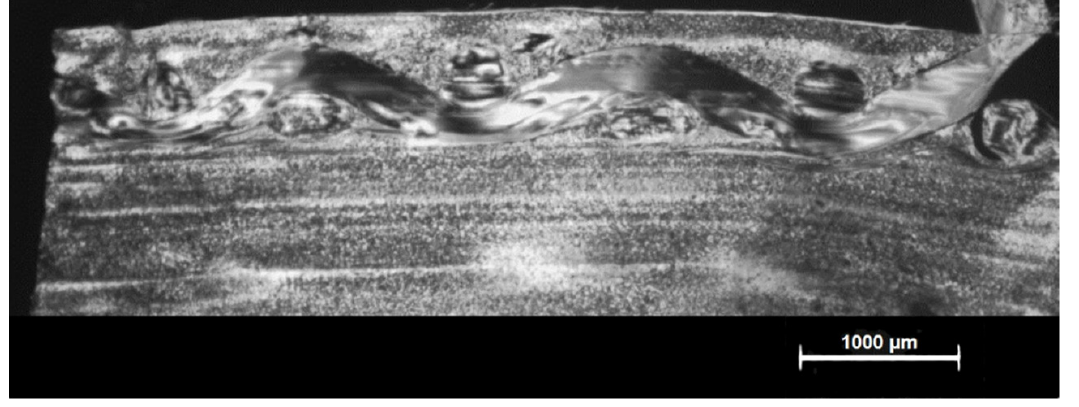
Figure 11. Impregnation of the PA thread in the PA matrix.